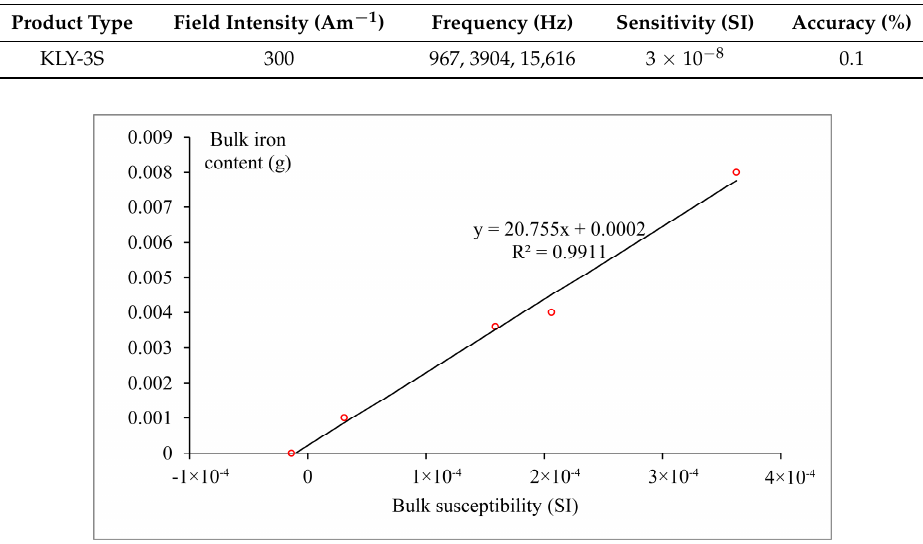
Table 3. Parameters of MFK.